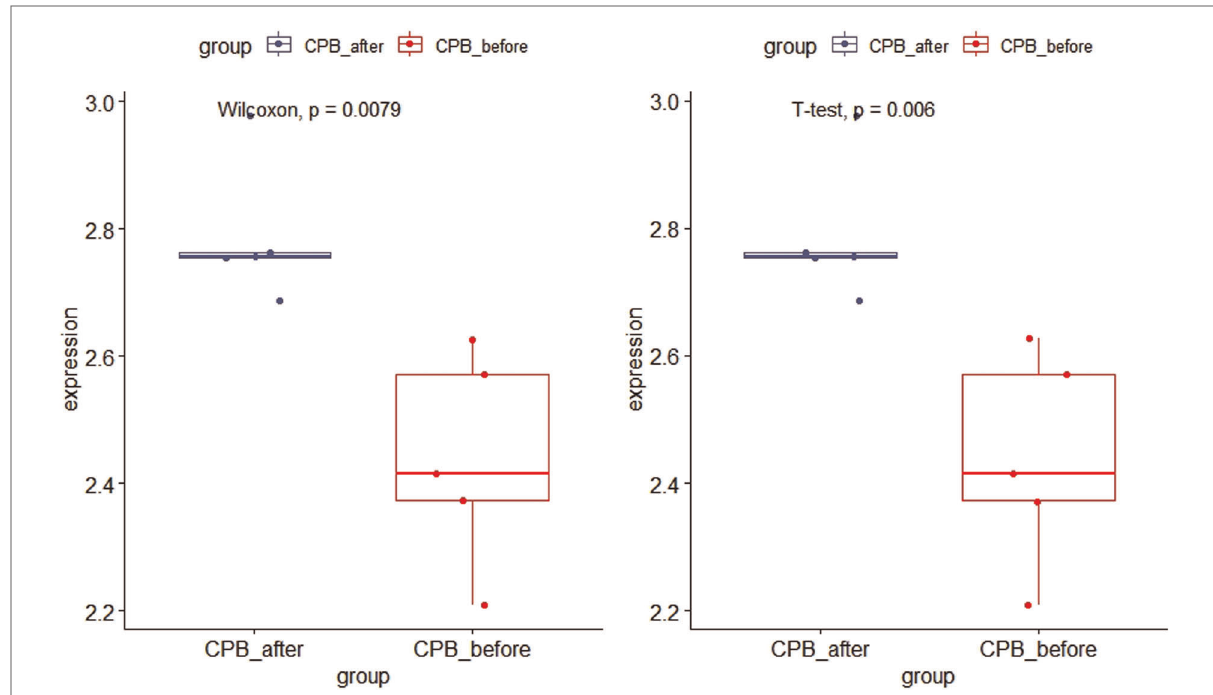
FIGURE 11 Box plots of CDKN1A gene expression in the validation set. The expression of CDKN1A in the GSE12486 validation dataset was signi fi cantly lower in the pre-CPB group than in the post-CPB group (Wilcoxon, P =0.0079; T-test, P =0.006).